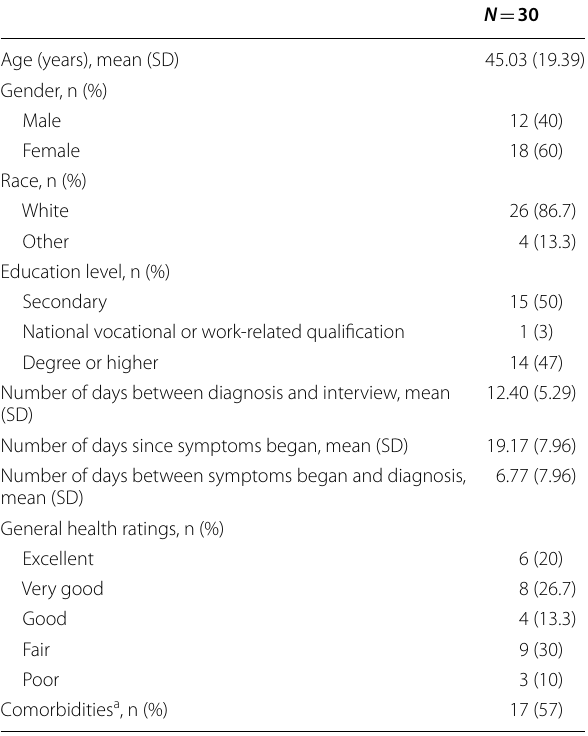
Table 1 Overview of patient sample